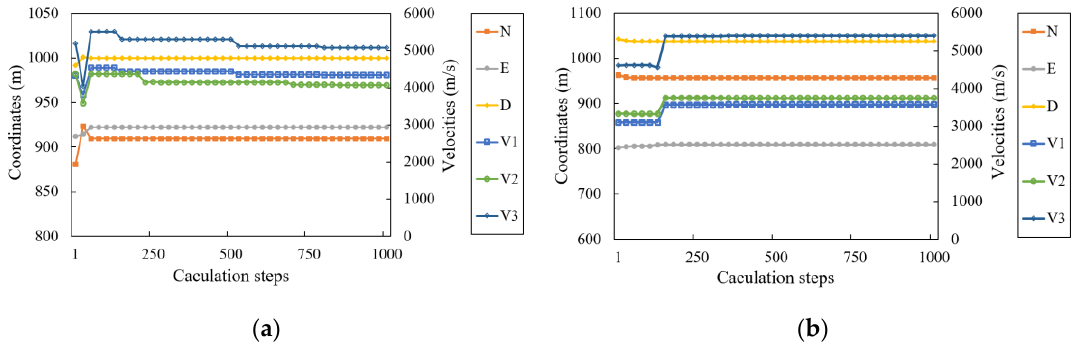
Figure 13. Search process for each dimension of PSO optimal sample: ( a ) event in the right tunnel; ( b ) event in the left tunnel. The horizontal coordinate represents the calculation step, and the vertical coordinate represents the calculation coordinate and velocity, respectively.